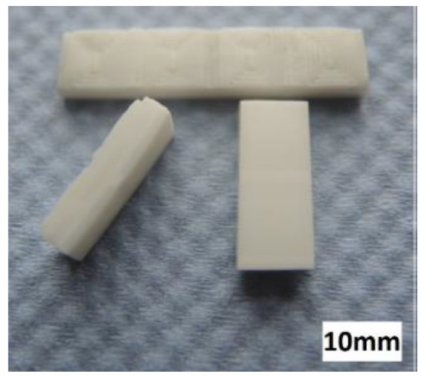
Figure 20. Sintered zirconia 4D components.